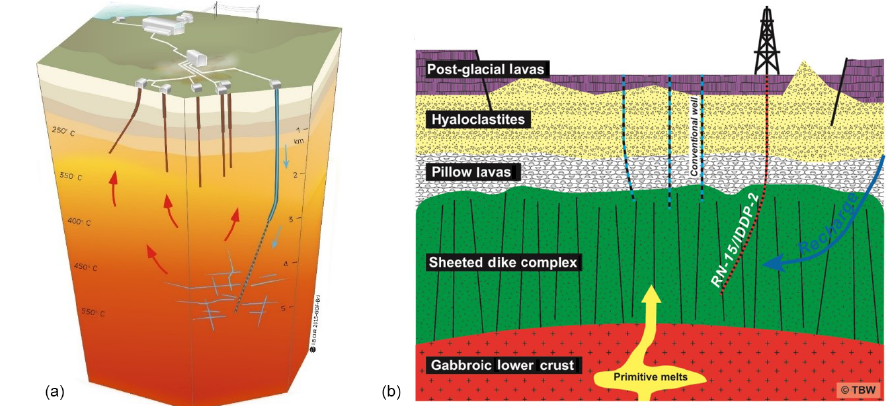
Figure 3. (a) Conceptual model of the roots of the Reykjanes Geothermal field indicating existing wells (brown) and the planned track of the IDDP-2 well (blue) to intersect the supercritical zone beneath the producing reservoir. (b) Schematic lithological model of the crust beneath the Reykjanes peninsula, which, below a thin apron of subaerial lava flows of Holocene age, is mostly composed of subglacial and marine tuffs, shallow marine sediments, and pillow basalts down to 2–3km depth, increasingly intruded by dikes with increasing depth. This culminates in a sheeted dike complex which extends for several kilometers, presumably underlain by a gabbroic lower crust.